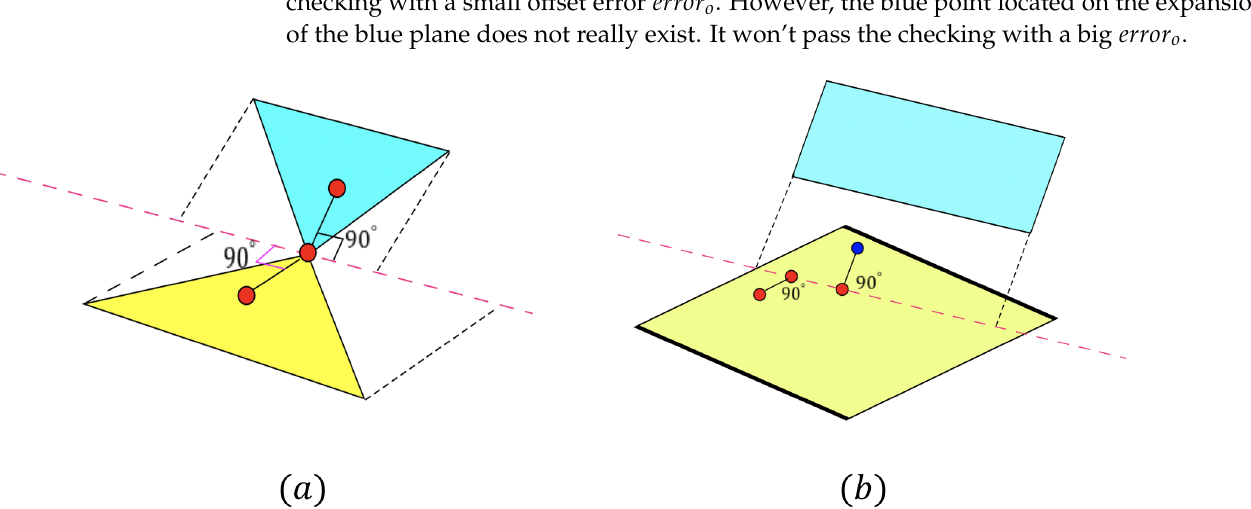
Figure 13. ( a ) Two planes only intersect at one point; ( b ) intersect line is on the expansion of one